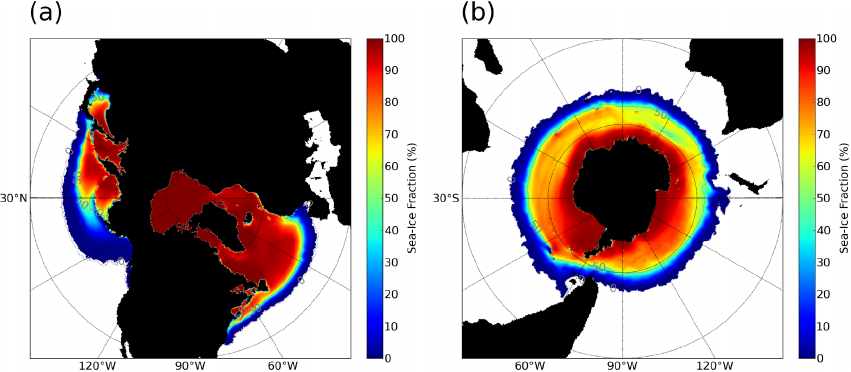
Fig. 3. Polar stereographic map of the boreal winter (JFM) sea-ice fraction (a) in the Northern Hemisphere and (b) in the Southern Hemi- sphere as simulated by the eddy-permitting model. Units in